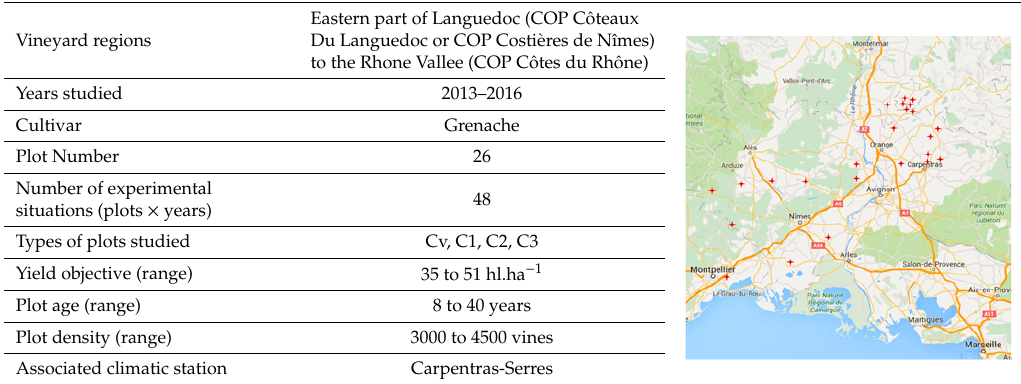
Table 1. Main characteristics of the plot network. COP: Certified origin product; Cv: Conventional production; and C1, C2 and C3: First, second and third years of conversion towards organic farming, respectively.